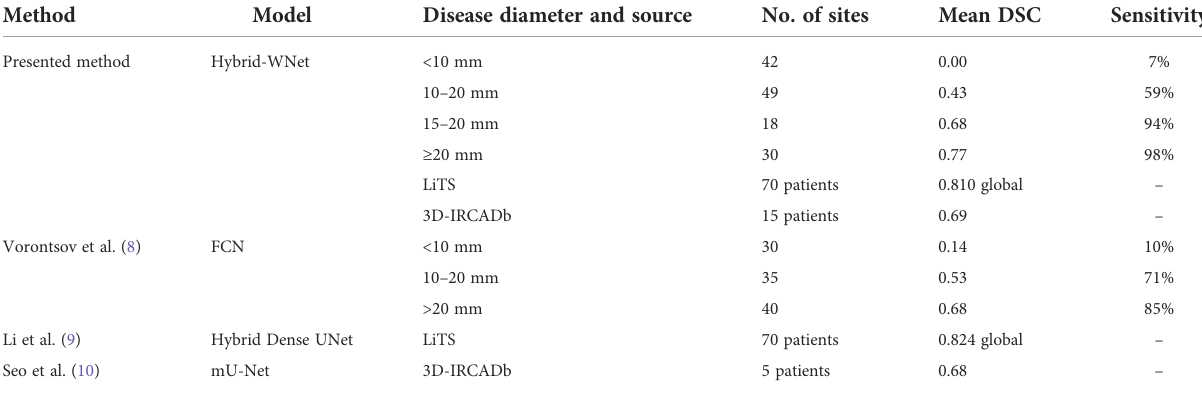
Patients were speci fi ed instead of sites for LiTS test